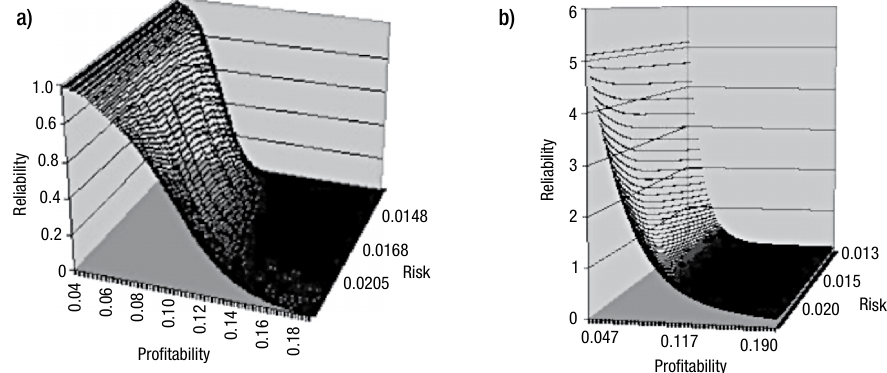
Fig. 3. The possibility surface of adequate portfolio and investor utility function (Rutkauskas, Stasytytė 2011): a) efficient surface (geometrical view) of the adequate portfolio;